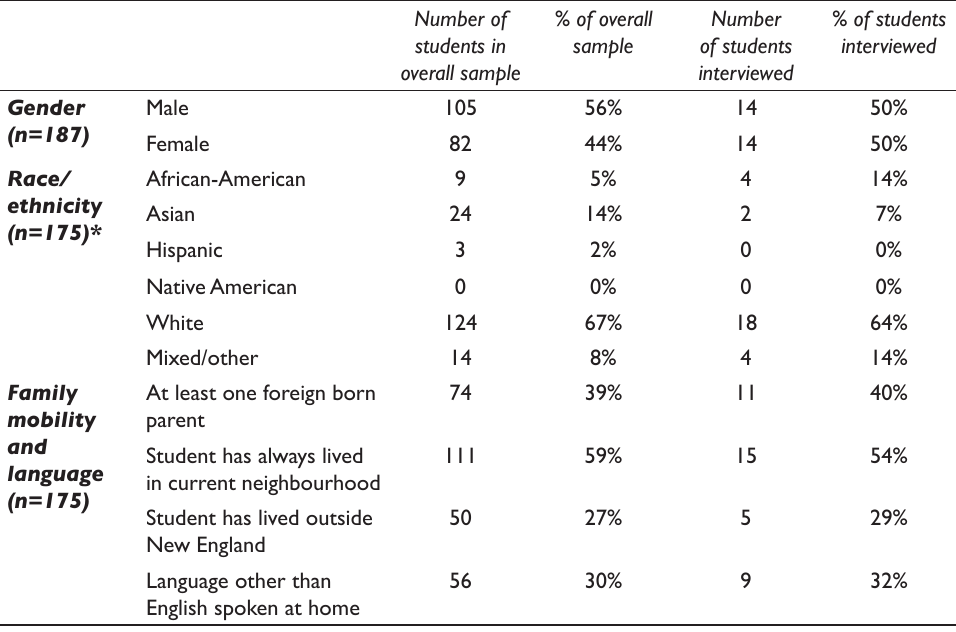
Table 1: Breakdownofsample(n=187